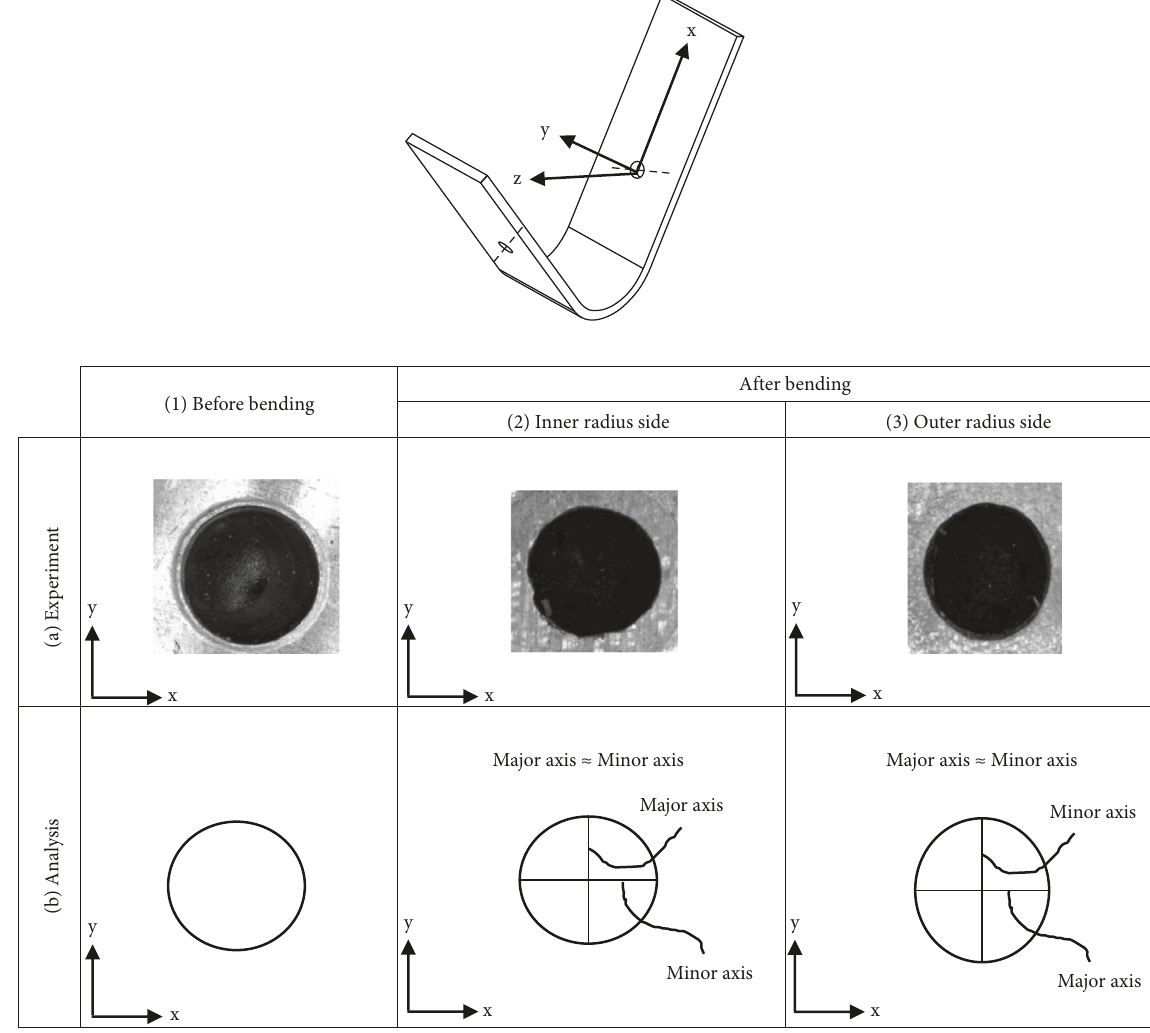
Figure 6: Illustration of plastic deformation and stress analysis on hole in the case of hole located next to bend radius zone (hole diameter: 5mm, bend angle: 60 ° ). (a) Experiment. (b)